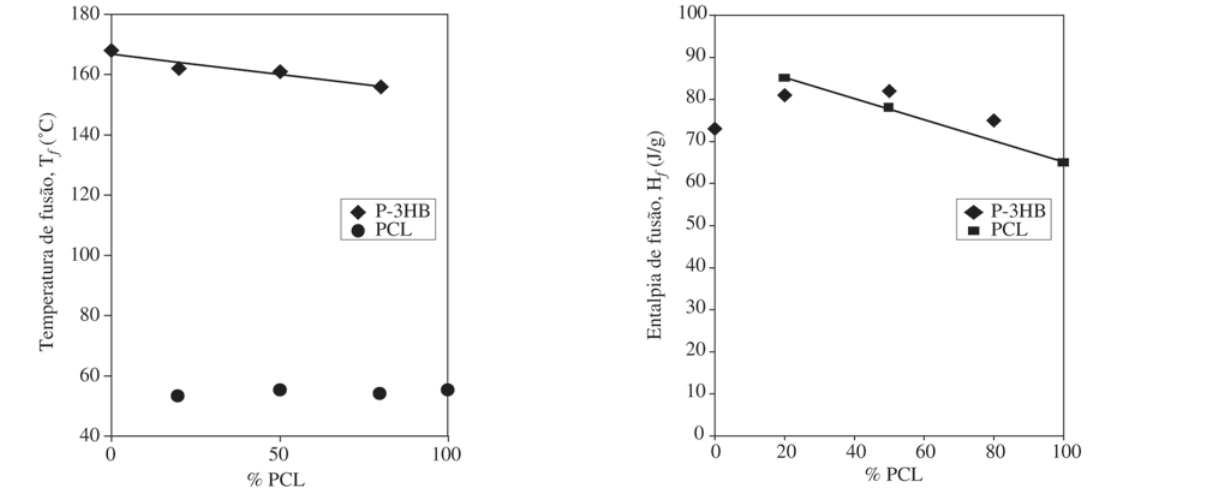
Figura 8. a) Temperaturas de fusão do P(3-HB) e da PCL em função da % de PCL na blenda; b) Entalpias de fusão do P(3-HB) e da PCL em função da % de PCL na blenda.